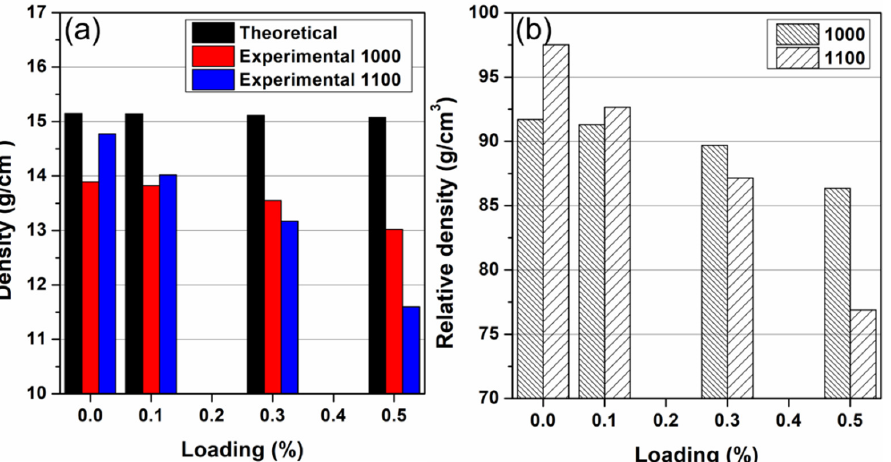
Figure 3. ( a ) Theoretical and experimental densities and ( b ) relative densities for the Cu-W matrix composites with different loadings of GO, processed at 1000 °C and 1100 °C.